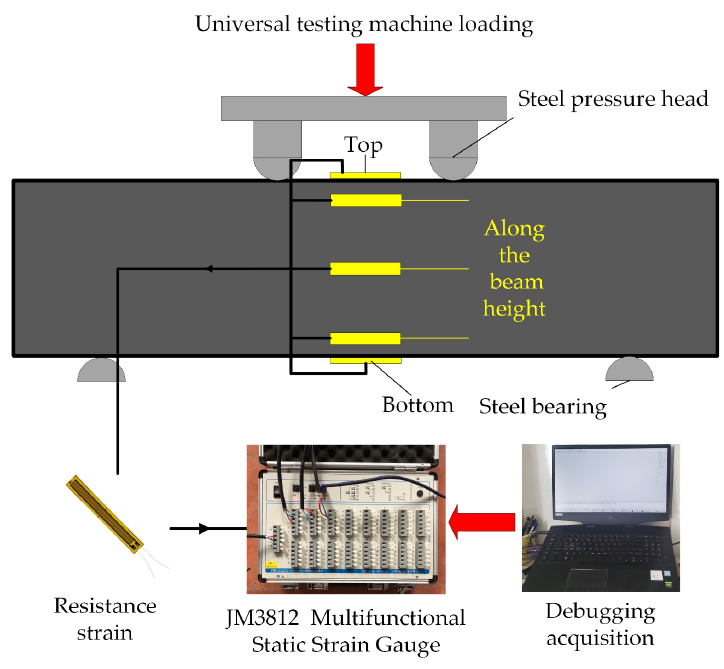
Figure 11. Strain acquisition system.